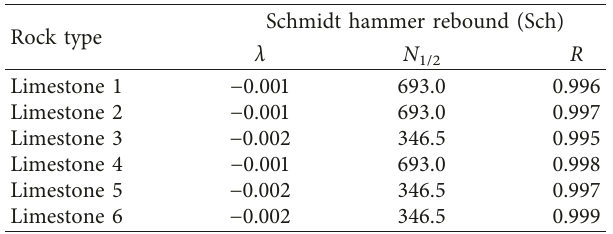
Figure 5: Determining the decay constant ( λ ) of samples under frost cycles: (a) limestone 1; (b) limestone 2; (c) limestone 3; (d) limestone 4; (e) limestone 5; (f) limestone 6. Table 7: The decay constant ( λ ), half-life ( N Table 5: The decay constant ( λ ), half-life ( N 1/2 ), and coefficient of 1/2 ), and coefficient of correlation ( R ) of Schmidt hammer rebound correlation ( R ) of unconfined compressive strength (UCS).